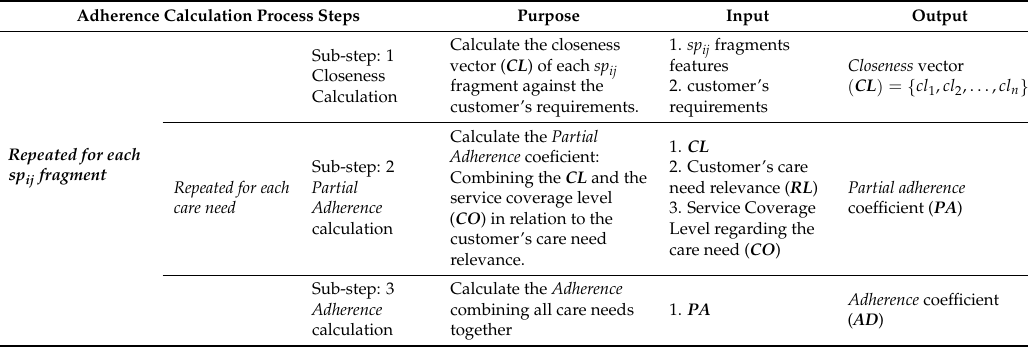
Table 6. Adherence calculation